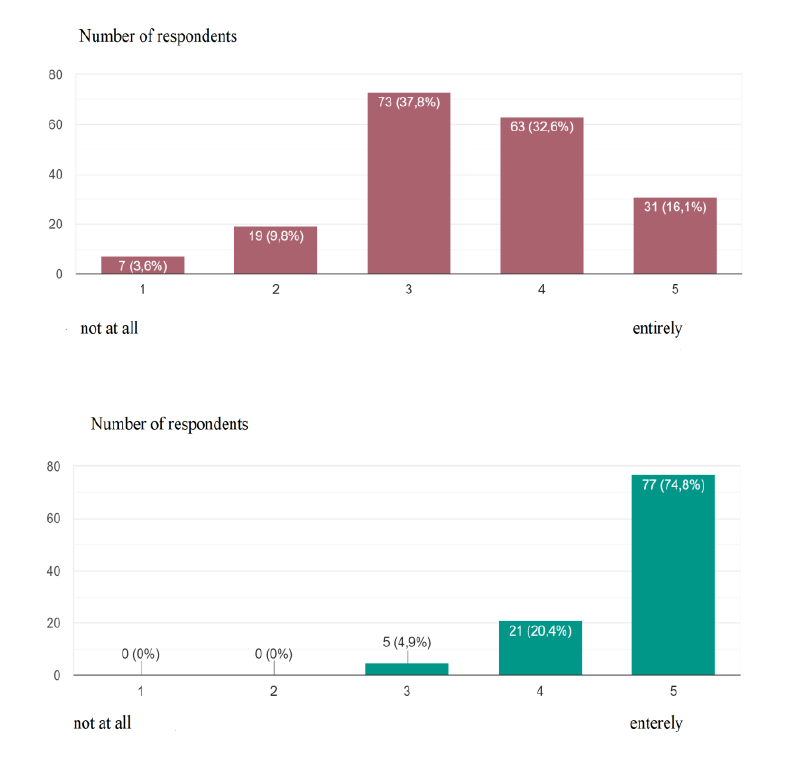
Fig. 2. Is STEM knowledge an important part of basic